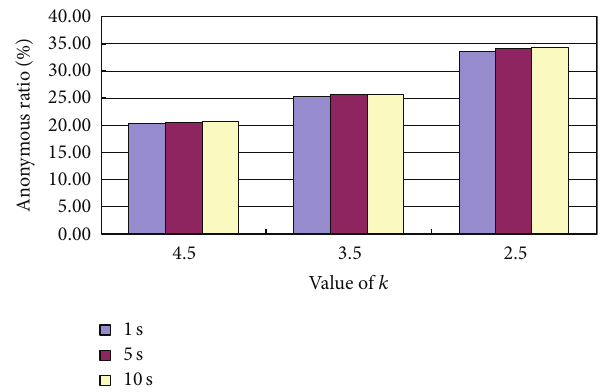
Figure 2: Ratio of the temporal-spatial anonymity with different waiting time and average anonymous request.